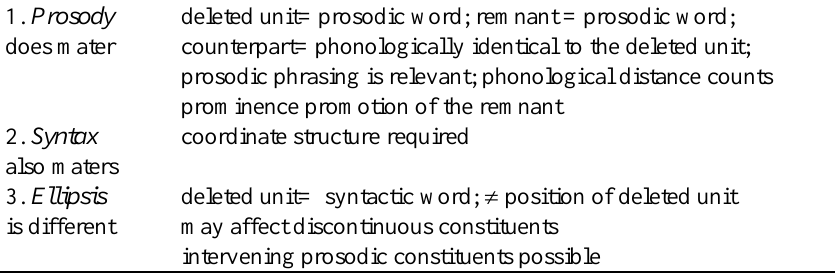
Table 1. Deletion under identity: summary